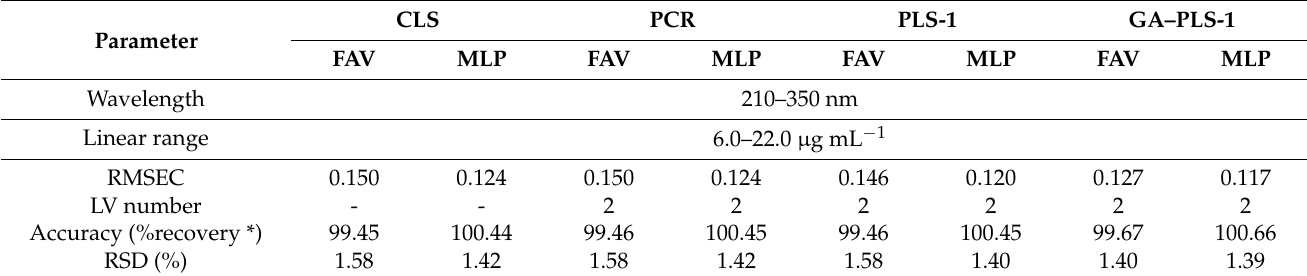
Table 4. Calculated validation parameters for the developed chemometric models.